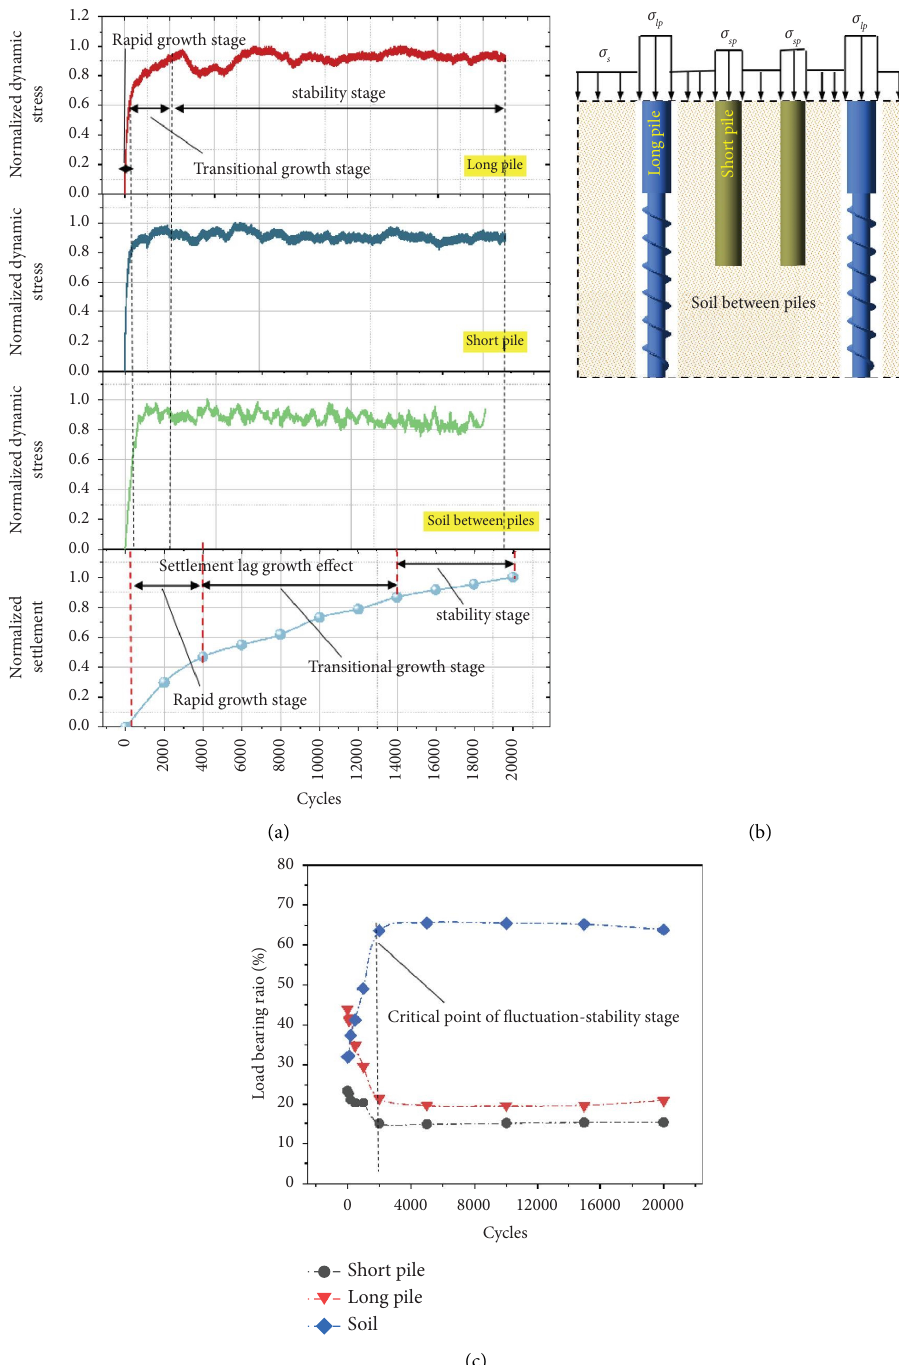
Figure 14: Stress deformation evolution of PC-LSPCF. (a) Normalized comparison of multiple source data. (b) Stress distribution for PC-LSPCF. (c) Load-bearing percentage of